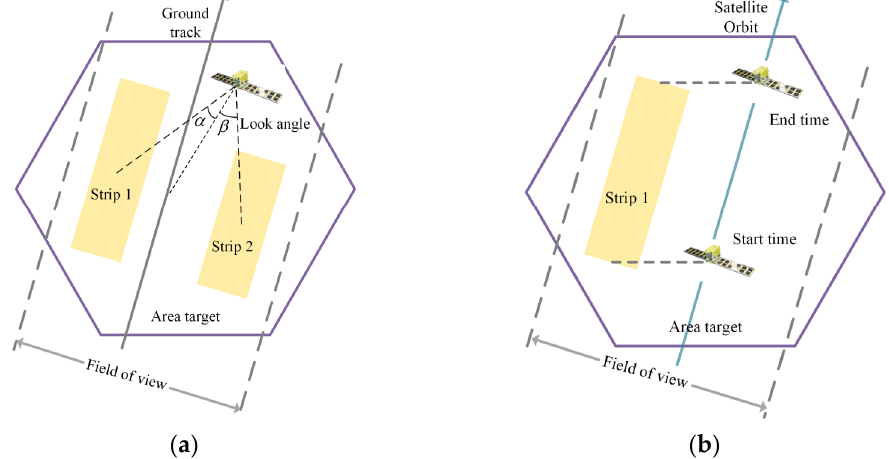
Figure 1. Schematic illustration of SAR satellite imaging. ( a ) Strips with different look angles; ( b ) start time and end time of a strip.